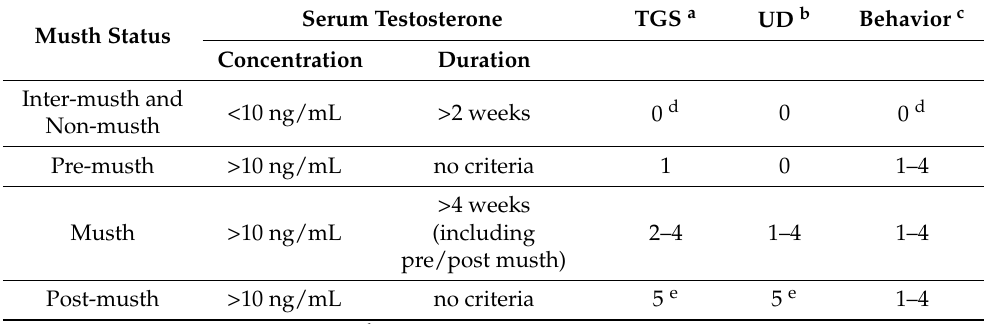
a Numerical values defined in Table 2. b Numerical values defined in Table 3. c Numerical values defined in Table 4. d Behaviors typical of musth and mild TGS were sometimes observed during inter-musth periods coincident with musth in other bulls, estrous in females, or breeding activity with females. e TGS/UD of 5 (versus 0) indicates cessation of TGS and UD but with signs of recent